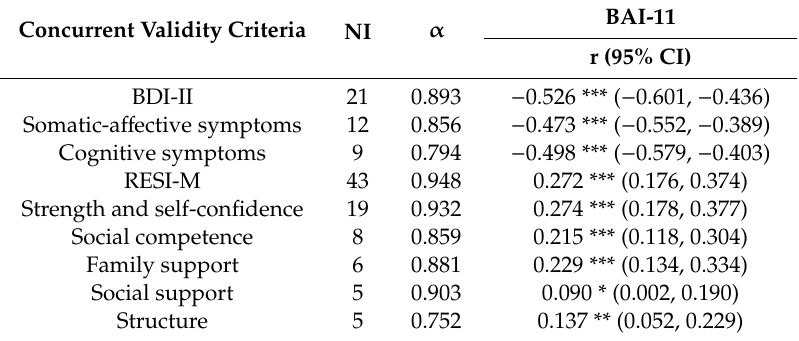
Table 7. Correlations between the BAI-11 and the two validity criteria (BDI-II and RESI-M). Concurrent Validity Criteria NI